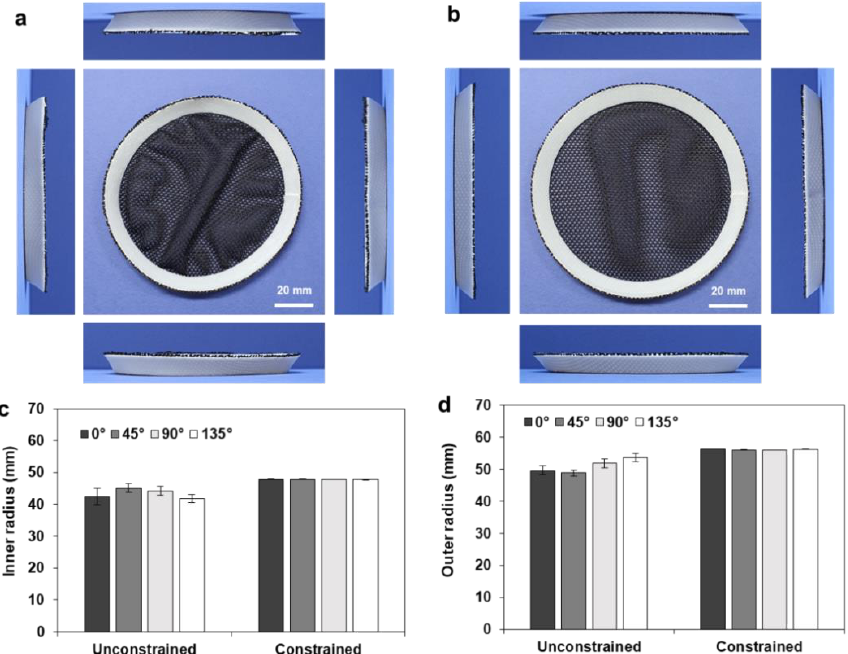
Figure 13. Deformed shape of the composite frame ( r = 60, w = 10 mm); ( a ) unconstrained deformation; ( b ) constrained deformation; ( c ) comparison of the inner radius ( r i *); ( d ) comparison of the outer radius ( r o *).